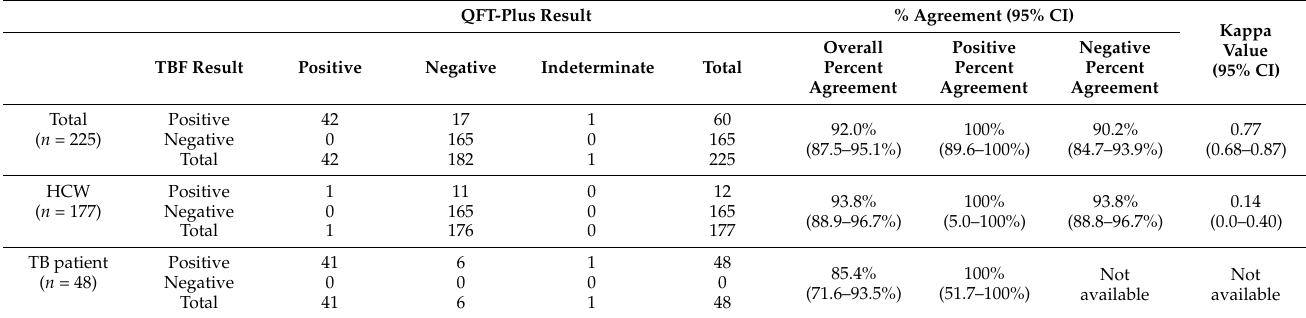
Table 1. Concordance between Standard E TB-Feron ELISA and QuantiFERON-TB Gold Plus assays. QFT-Plus